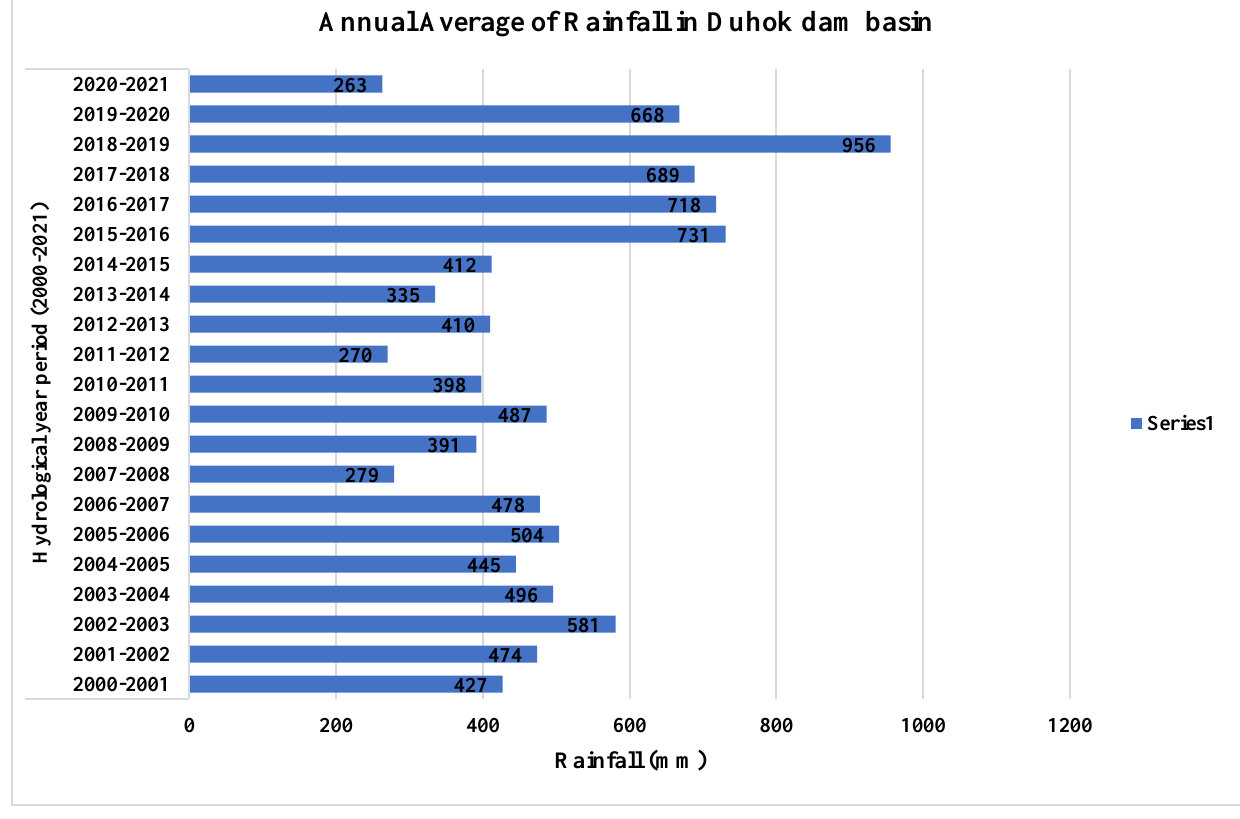
Figure 5. Annual Average of Rainfall in Duhok dam